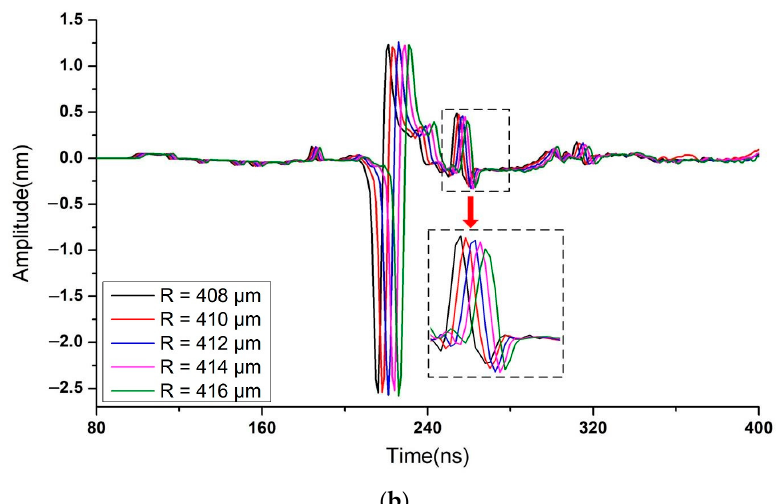
Figure 10. Simulation results of displacement at the ring center and comparison of peak-to-peak amplitudes of the focal shear echoes when R varies near ( a ) 190 μ m and ( b ) 410 μ m.